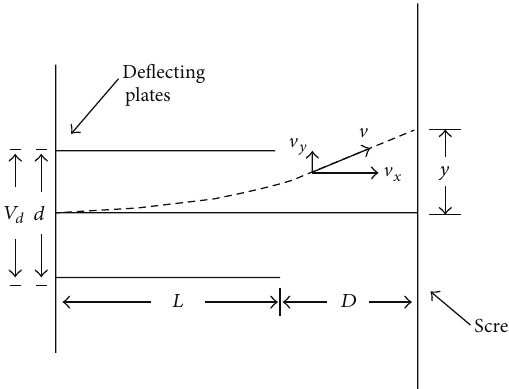
Figure 5: Effect deflection plates with electrical energy.